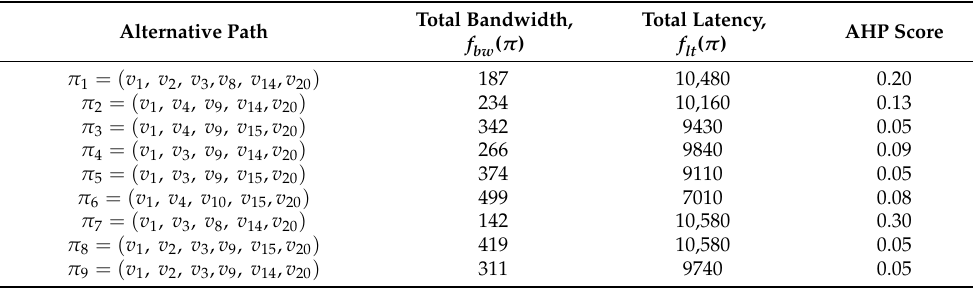
Table 4. The Pareto set of the alternative paths for graph A. Alternative Path